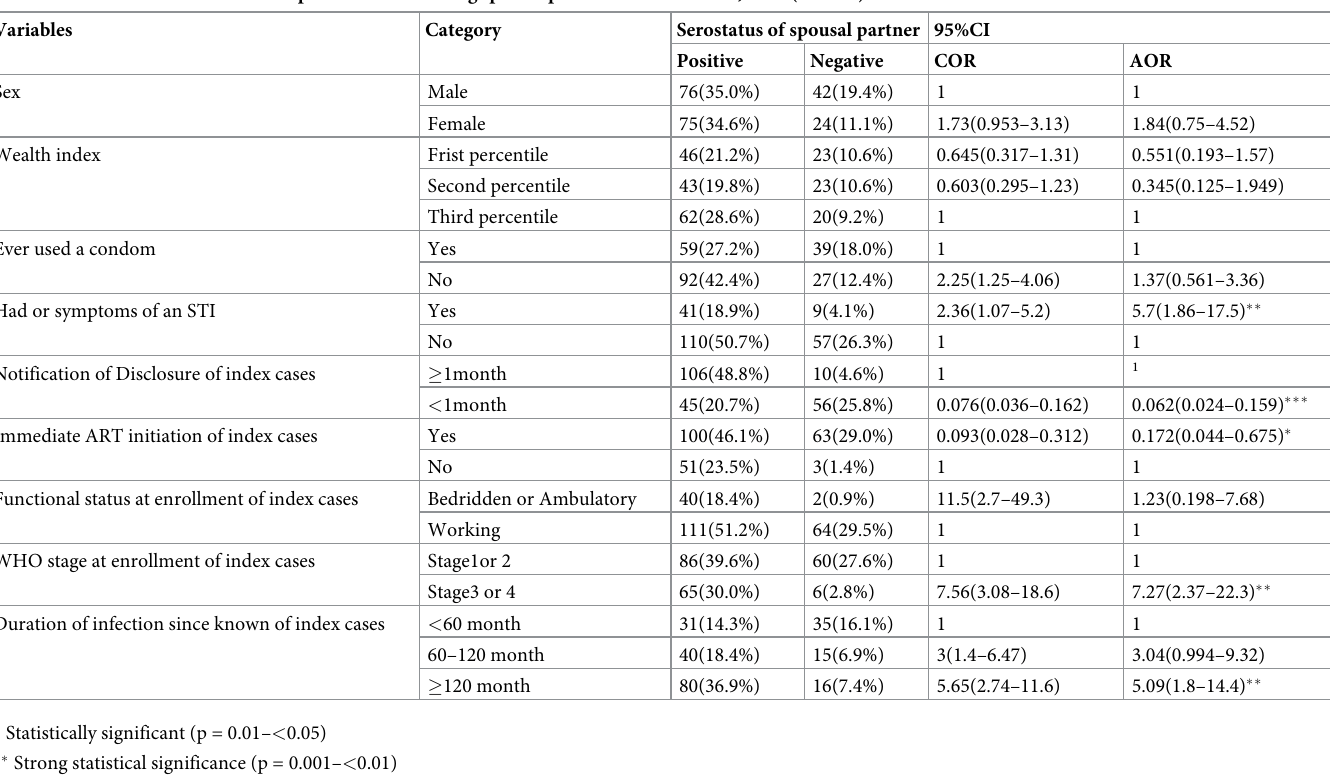
Table 8. Factors associated with seropositive status among spousal partners in Sodo Town, 2021 (n =